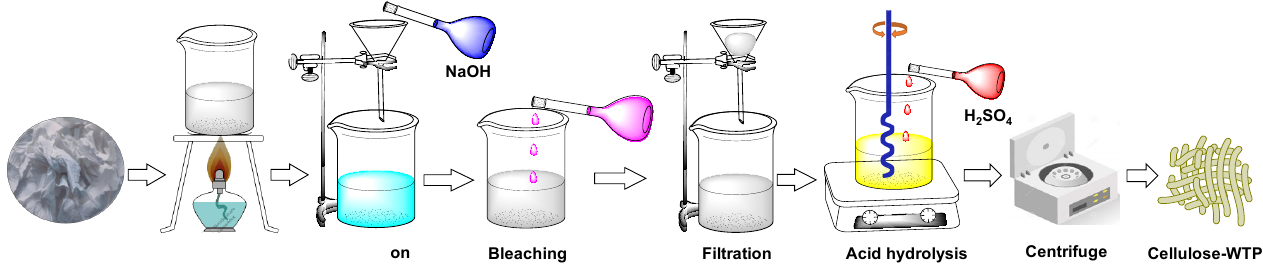
Figure 1. Preparation of cellulose-WTP particles from WTP.